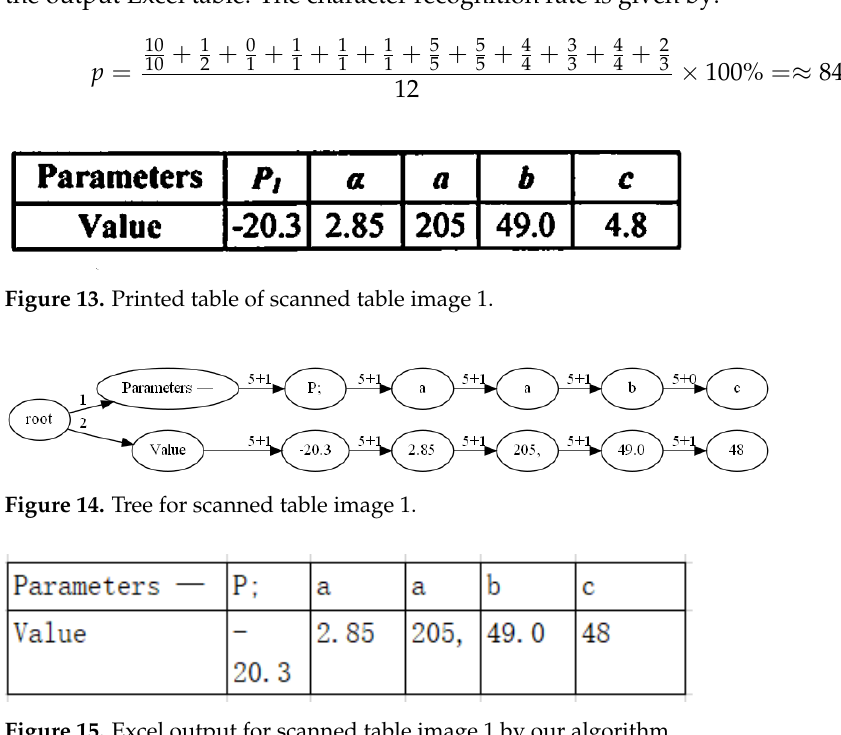
Figure 15. Excel output for scanned table image 1 by our